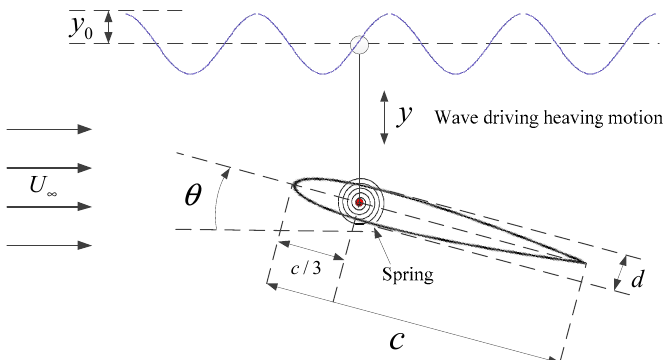
Figure 2. Schematic illustration of the semi-active flapping foil for the wave glider, with a wave heaving driving heaving motion.